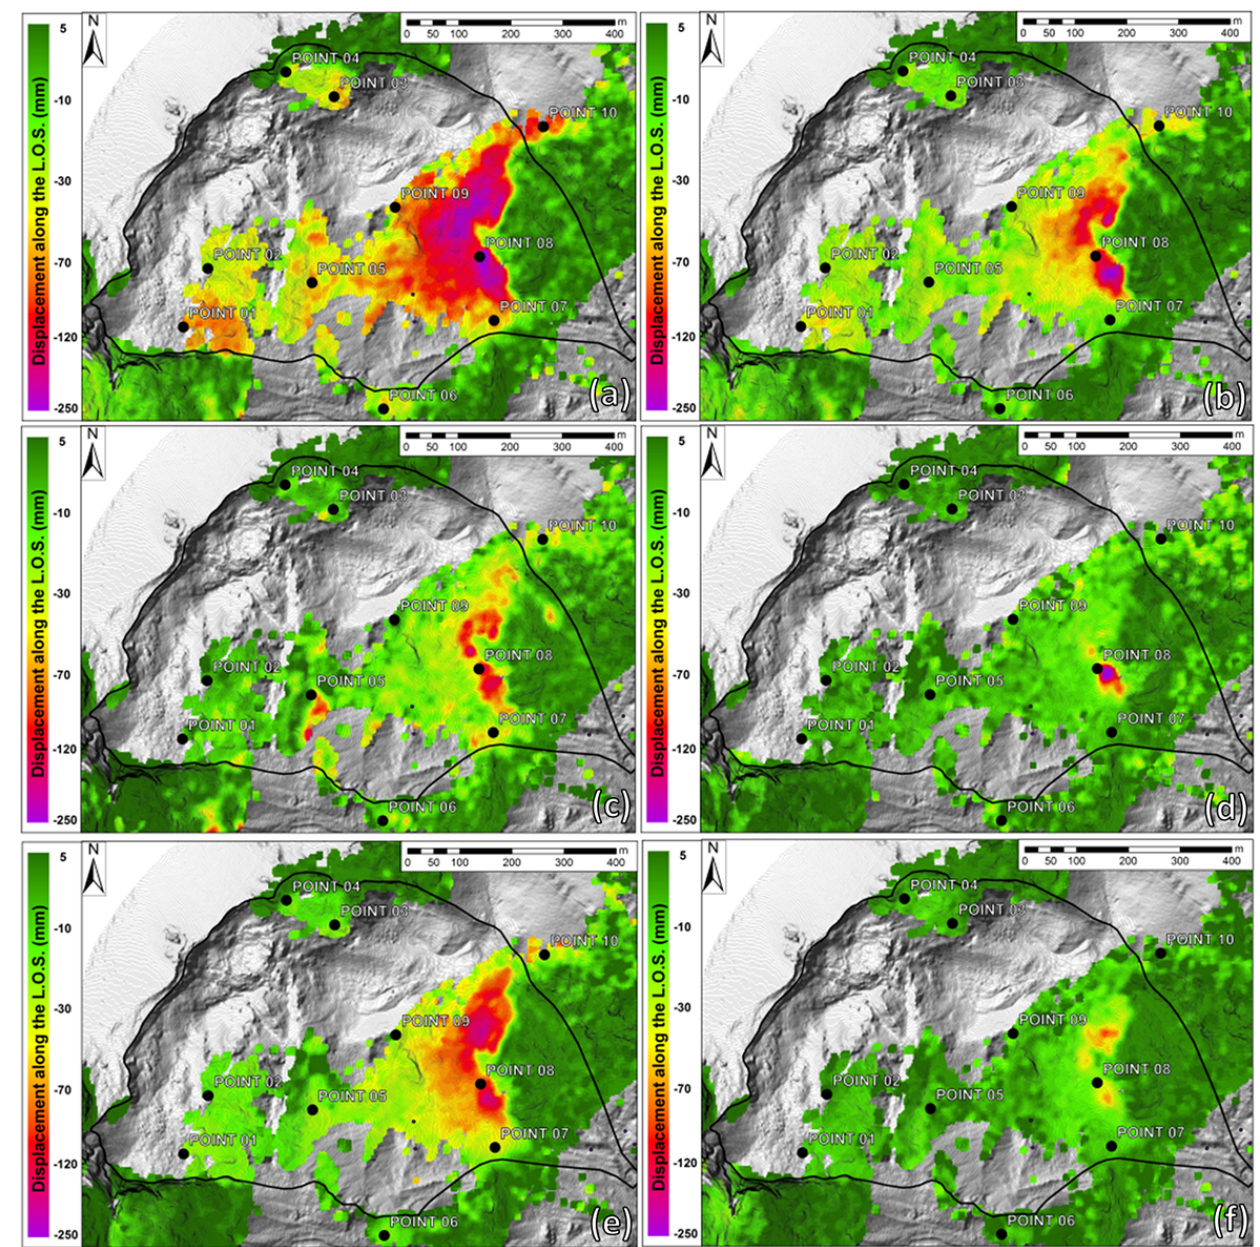
Figure 9. Selection of MCD maps from the GB-InSAR dataset: (a) December 2010 (232mm cumulated peak displacement); (b) January 2011 (214mm); (c) March 2011 (173mm); (d) May 2011 (244mm); (e) November 2011 (174mm); (f) November 2012